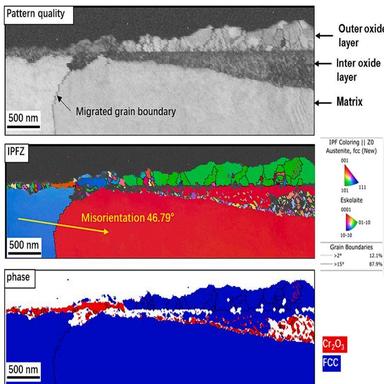
Pattern quality map, IPFZ map and phase map of the oxide scale after exposure in 600 ◦C/25 MPa SCW for 24 h (chromite oxides, NiO, Fe3O4 and austenite matrix in blue, Cr2O3 in red, step size = 10 nm). (For interpretation of the references to colour in this figure legend, the reader is referred to the web version of this article.)